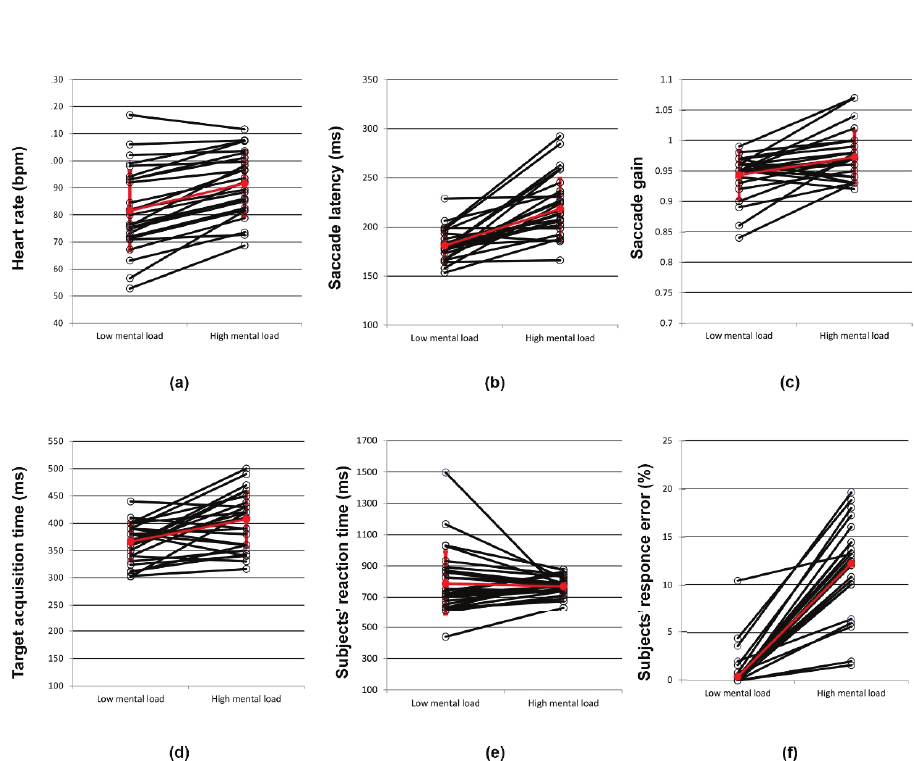
Figure 1. Heart rate (a), saccade latency (b), saccade gain (c), latency of target acquisition; i.e., fixation on target of interest (d), participants’ reaction time (e), and response errors (f) in post-saccadic discrimination task under low and high cognitive loads. Black lines represent changes from low to high cognitive load for each participant. Red circles with vertical lines express the mean ± SD under the low and high loads; except for response errors that the red circles express median values. Red diagonal lines represent changes in the means for (a–e) and changes in the medians for (f) from low to high cognitive